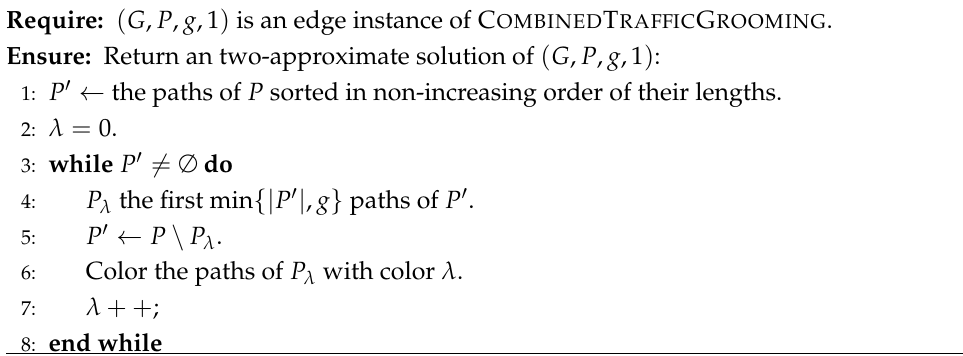
Algorithm 2 G ROOM